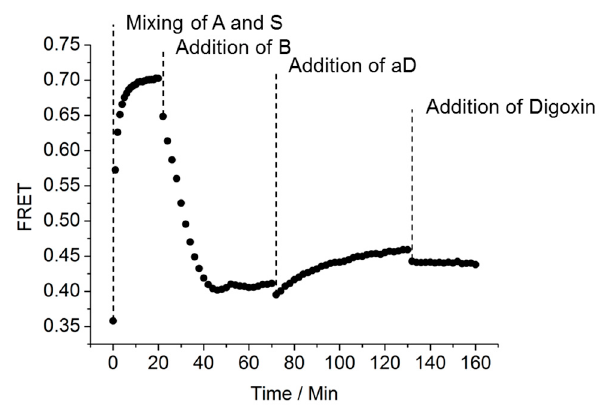
Figure 5. Real-time study of the change in FRET value over time when mixing SDC assay: Mixing of A and S (20 nM, A:S = 1:1), addition of B (20 nM, 1 eq.) to the AS solution, addition of aD (20 nM, 1 eq.) to the ABS solution, addition of digoxin (200 nM, 10 eq.) to the ABS-aD solution. Zero (0) min is defined as data obtained right after mixing of A and S.